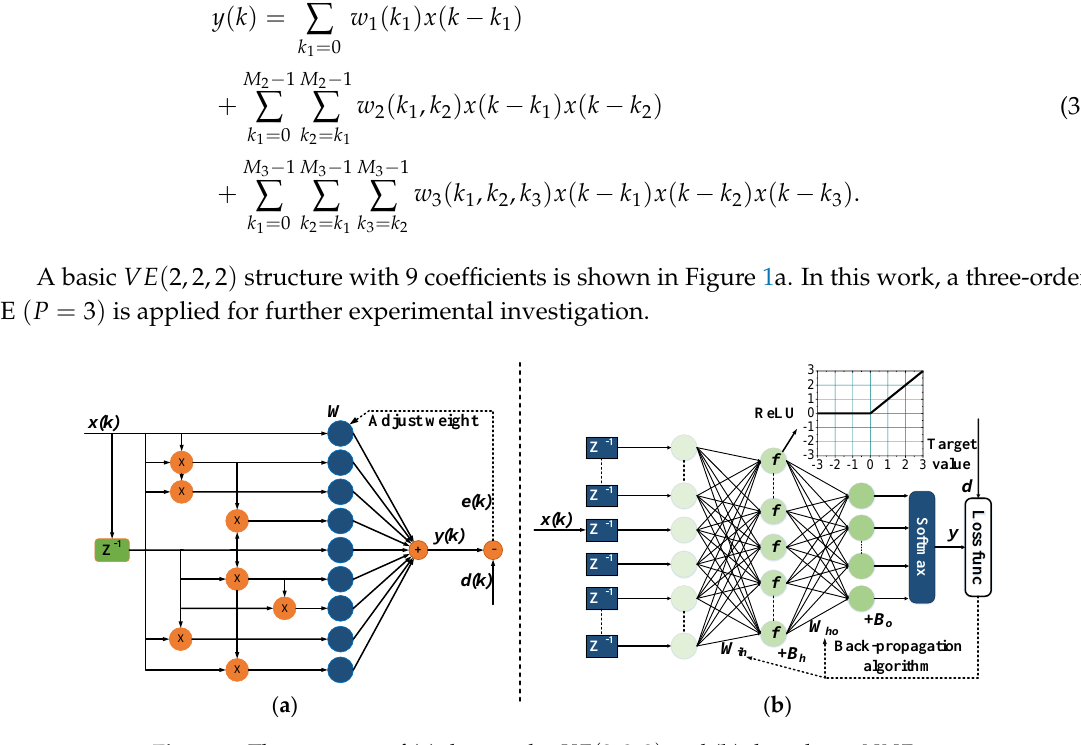
Figure 1. The structure of ( a ) three-order VE ( 2,2,2 ) and ( b ) three-layer NNE